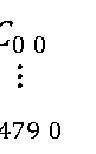
Figure 3. Distribution Matrix.